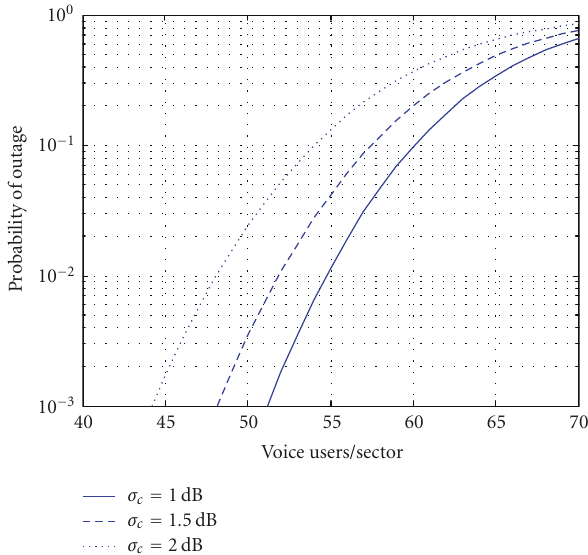
Figure 4: Outage probability of the sector for voice users only.